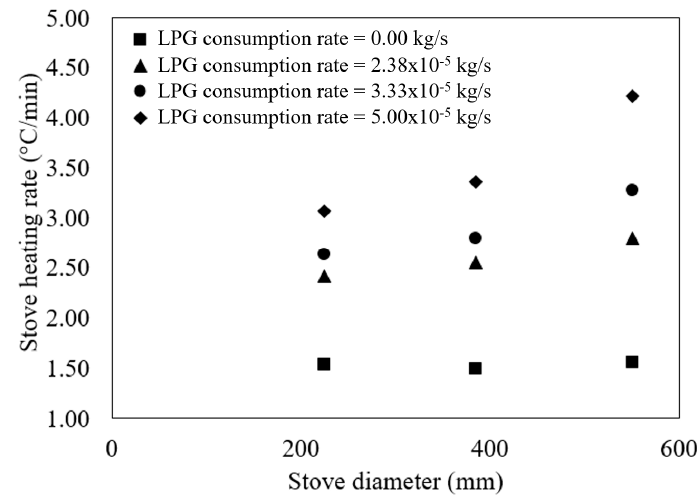
Figure 2. Relationship between stove heating rate and stove diameter. Processes 2020 , 8 , x FOR PEER REVIEW